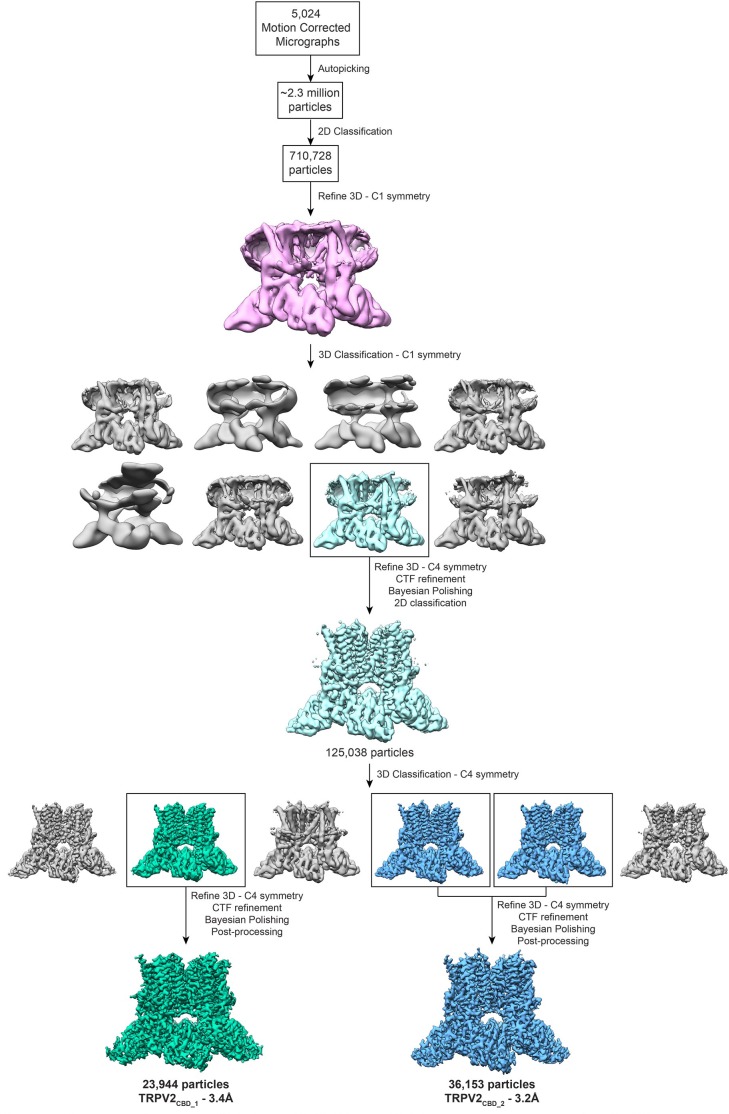
CBD-bound TRPV2 cryo-EM data processing.Workflow for 3D reconstruction resulting in two distinct CBD-bound TRPV2 structures.